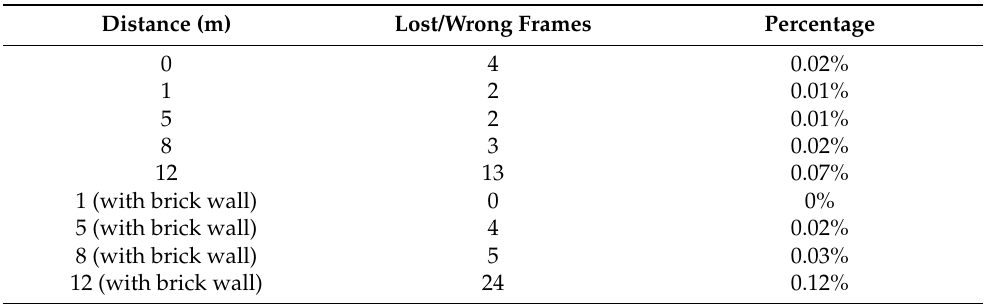
Table 7. Lost/wrong frames at different distances even with a brick wall in